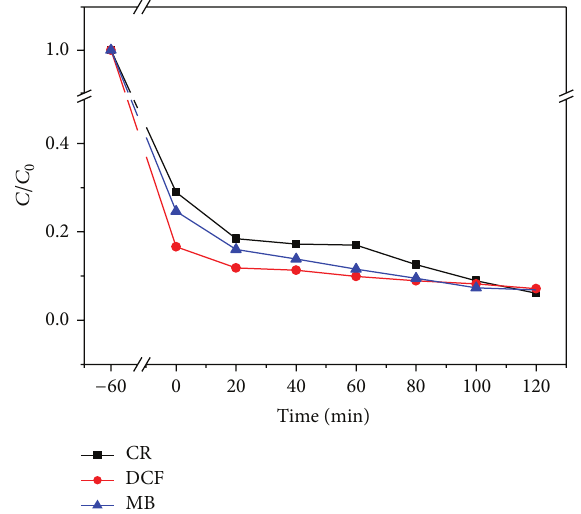
Figure 9: The photocatalytic performance of S2-500 in the degra- dation of different organic